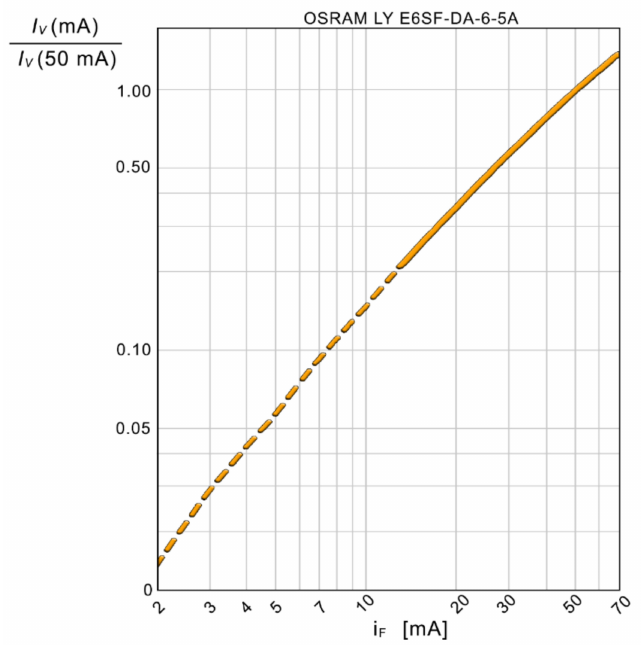
Figure 9. LY E6SF LEDs: intensity vs. bias current when the temperature of the soldering point is 25 ◦ C. I V represents the light intensity emitted by the LED and i F bias current. The light intensity is normalized to 1 when the bias current is 50